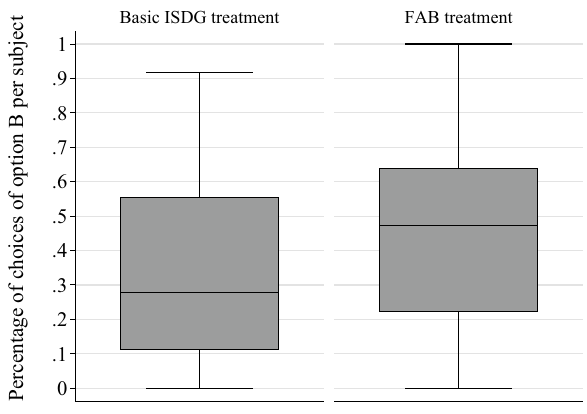
Figure 1. The distribution of the percentage of choices of option B per subject in the basic ISDG and FAB treatments.